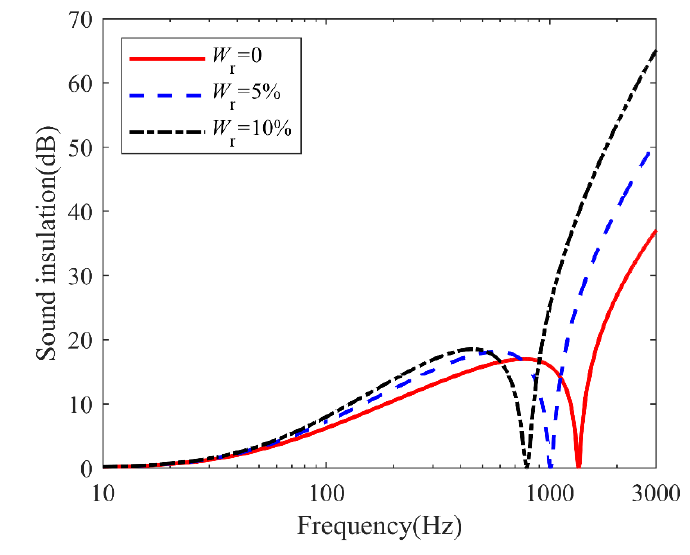
Figure 10. Effect of particle mass fraction of reinforcement on sound insulation.